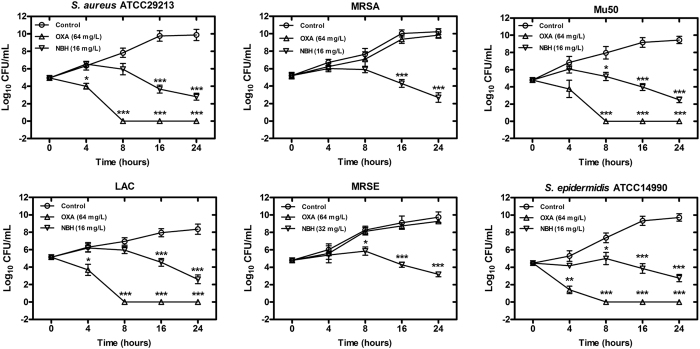
Effects of NBH on the growth of bacterial colonies.NBH and oxacillin were added to cell cultures to final concentrations of 16 (32 mg/L to MRSE) and 64 mg/L, with addition of equal volumes of sterile water as the controls. Aliquots of each culture were collected at 0, 4, 8, 16 and 24 h, diluted and inoculated on solid agar. CFUs were calculated from the number of colonies grown on plates, and data are represented as mean ± SD for three replicates. *P < 0.05, **P < 0.01 and ***P < 0.001 versus control; OXA, oxacillin.